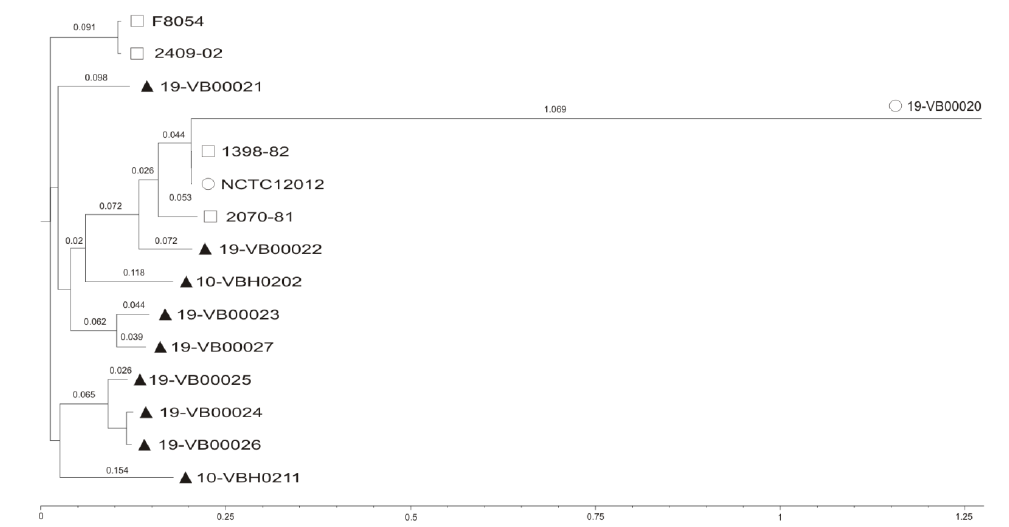
Figure 1. Single nucleotide polymorphism (SNP)-based phylogeny tree of Vibrio cincinnatiensis strains: veterinary isolates ( ▲ ), human isolates ( О ), or isolates of unknown origin (□) . SNP tree was conducted using CSIPhylogeny 1.4 under default settings and the exclusion of heterozygous SNPs. Single nucleotide polymorphisms (SNPs) were called by mapping to the V. cincinnatiensis NCTC12012 genome as reference. Scale bar represents the number of nucleotide substitutions per site and numbers indicate branch length (accession numbers for strain F8054: CP046848 and CP046849; for 1398-82: